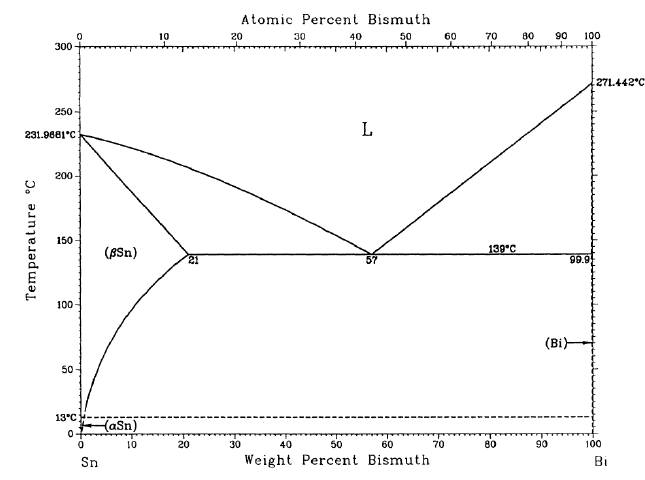
Figure 3. Phase diagram of Sn–Bi binary alloy [26]. Table 2. Solid-phase line temperature, liquid-phase line temperature, and melting range of